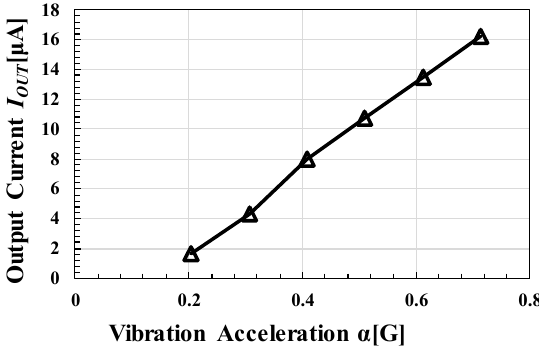
Figure 24. Measured I OUT as a function of α ( V OUT = 2 V, f IN = 195 Hz, f CLK = 5 MHz).